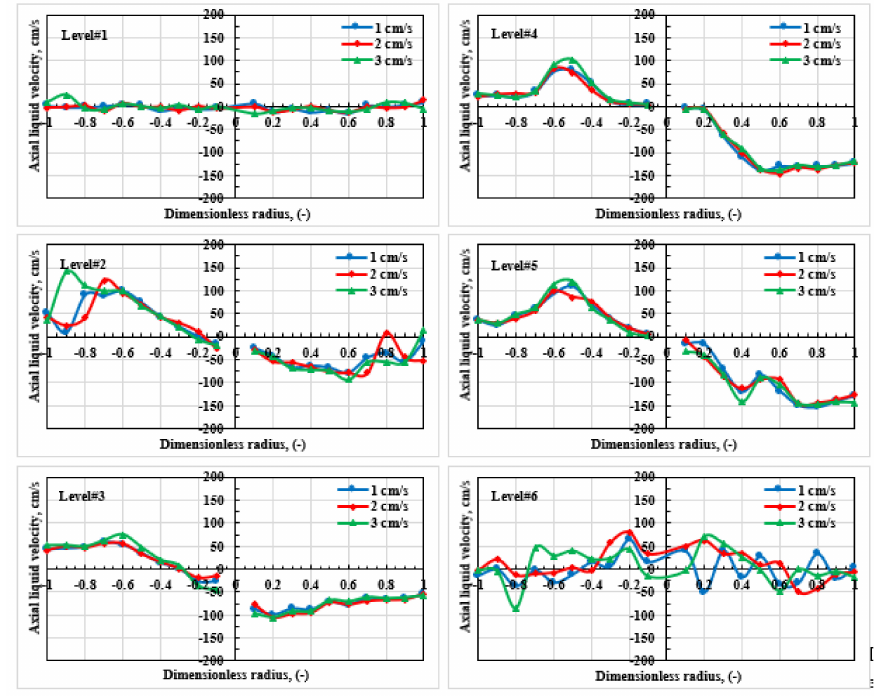
Figure 15. Local axial velocity profiles at different height of split airlift reactor operated under different gas